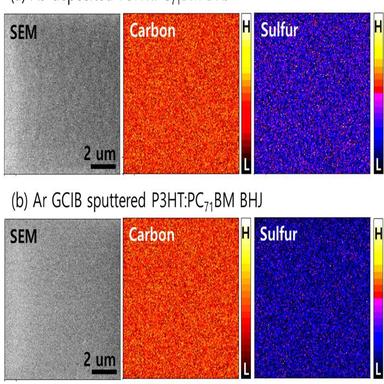
J-V characteristics (AM 1.5, 100 mW cm−2) of as-deposited and solventannealed P3HT:PC71BM organic photovoltaic devices.